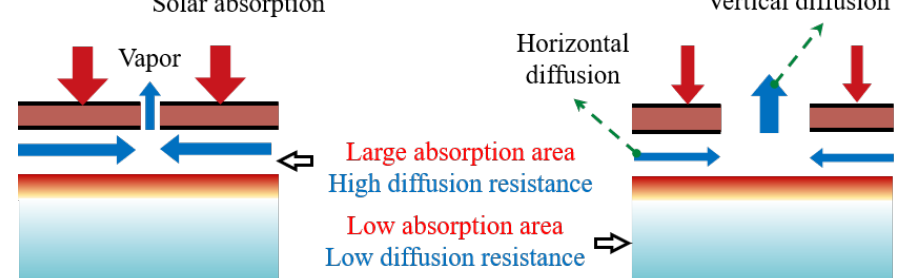
Figure 7. Mechanism diagram of the downward heat transfer and the vapor diffusion for SCE.